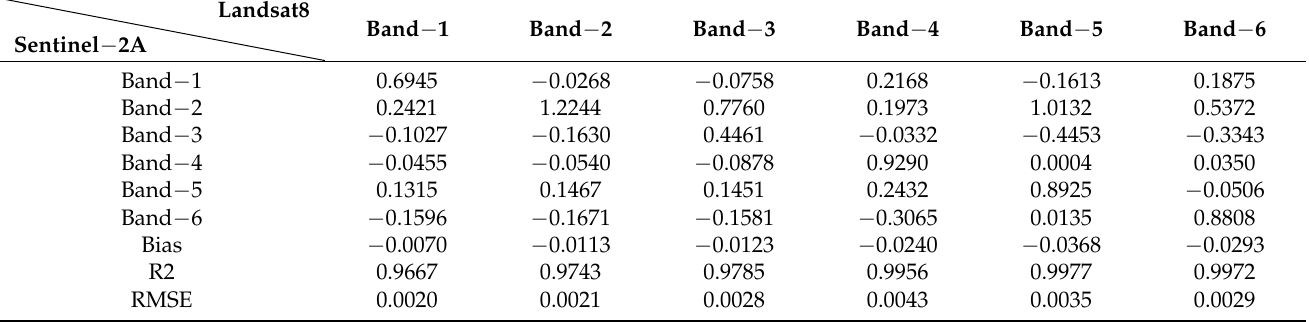
Table 4. Transfer coefficient and error of polygon − multi between Sentinel − 2A and Landsat8 −